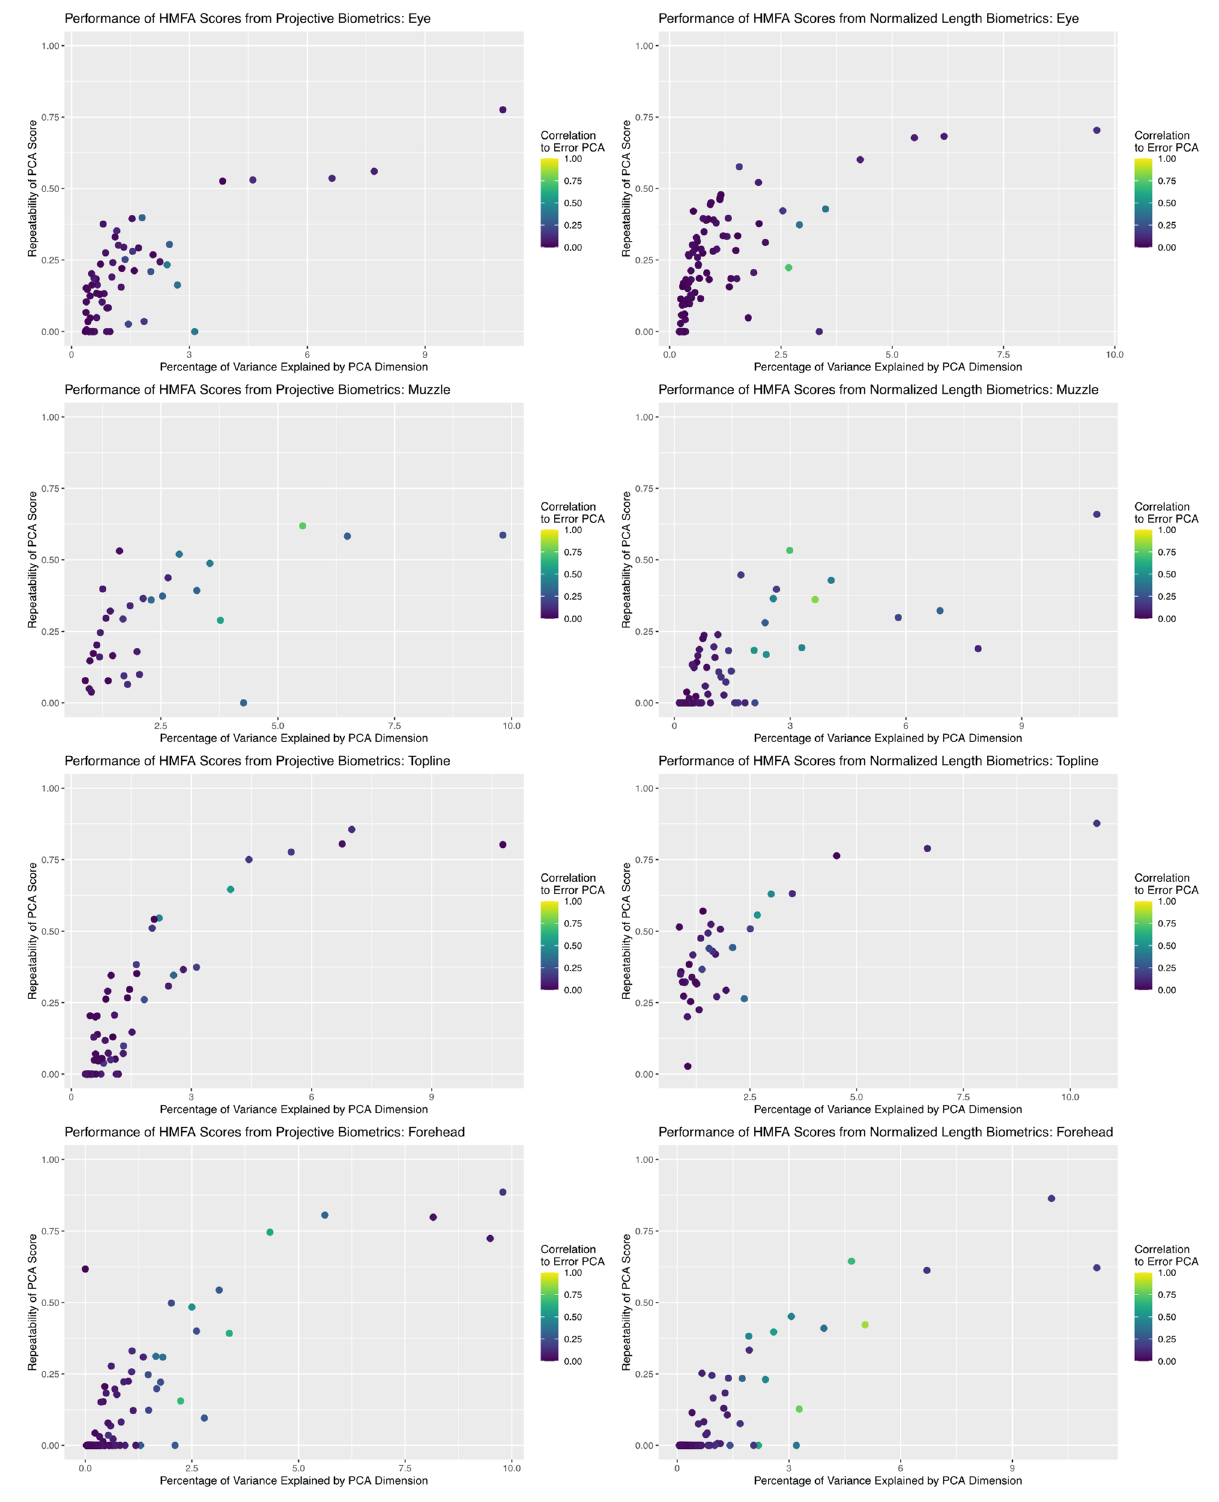
Figure 8. Comparison of the relationship between the proportion of total variance explained by each dimension returned by HMFA analysis and the repeatability estimate of the partial scores. For both measurement systems, basis dimensions with intermediate repeatability estimates align with the subspaces generated for systematic error structures, which may indicate they are concentrating variance attributable to lurking